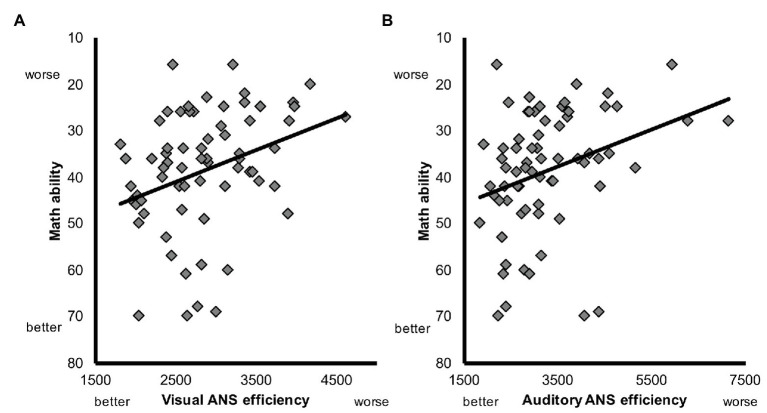
Scatterplot depicting the relation between math ability [Test of Early Mathematics Ability (TEMA) raw score], (A) visual ANS efficiency, and (B) auditory ANS efficiency prior to training.